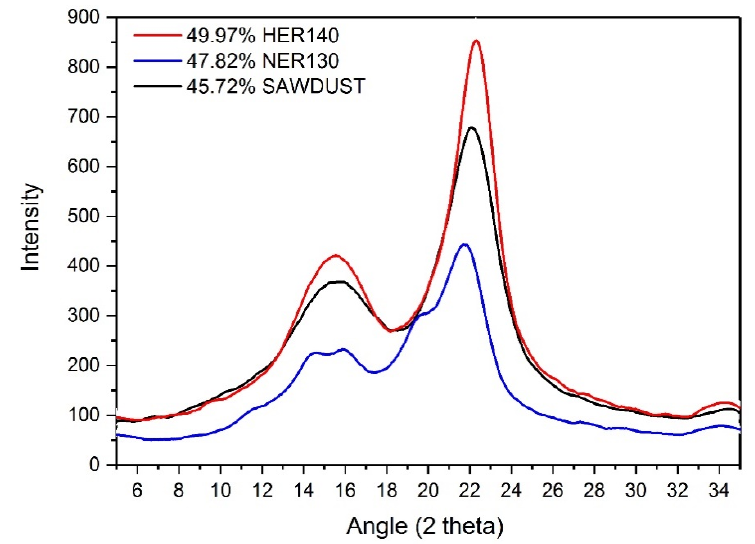
Figure 3. X-ray diffractograms of residual eucalyptus sawdust in natura and after acid (HER140) and